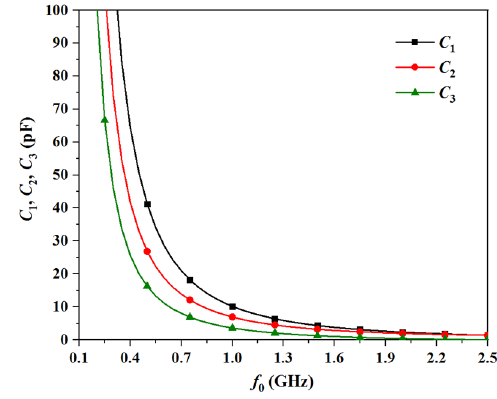
Figure 8. Curves of C 1 , C 2 , and C 3 versus the tuning frequency f 0 .